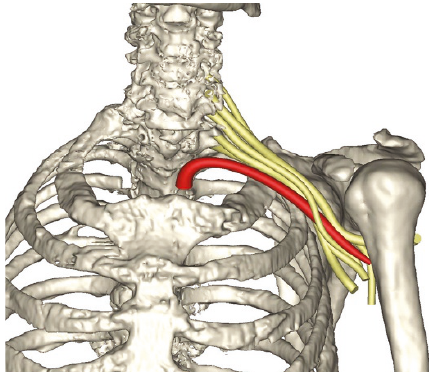
Figure 4: Surface reconstruction of the brachial plexus and intersecting subclavian artery.